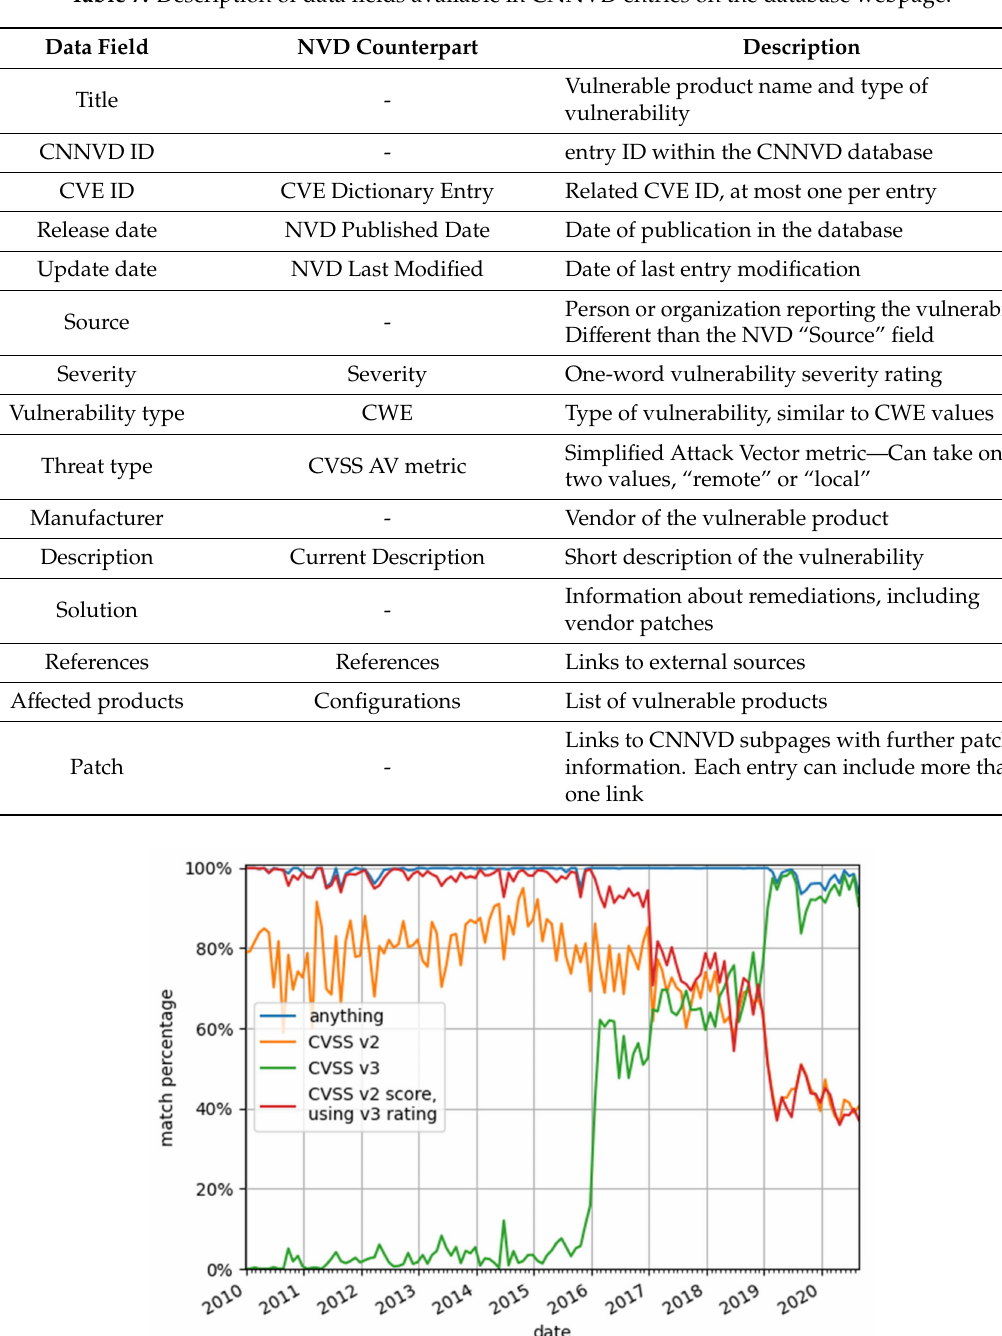
Table 7. Description of data fields available in CNNVD entries on the database webpage.